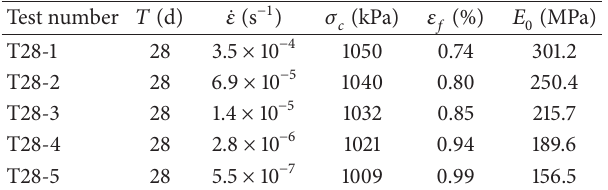
Table 1: Experimental data of cement-mixed gravelly soil at differ- ent strain